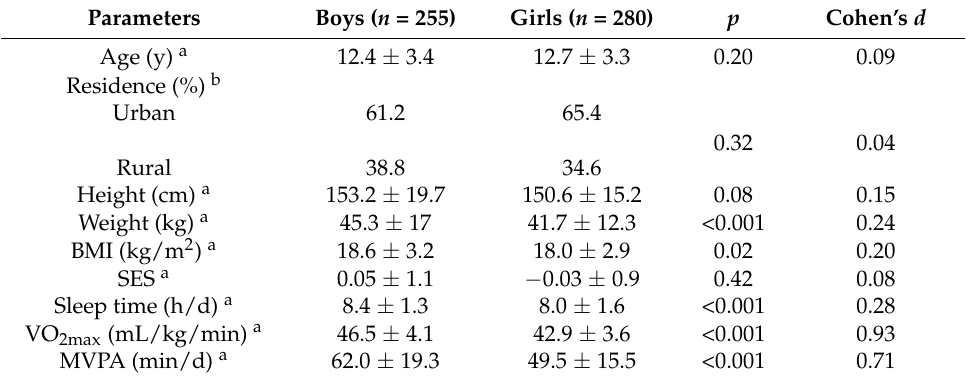
Table 1. Descriptive characteristics of the